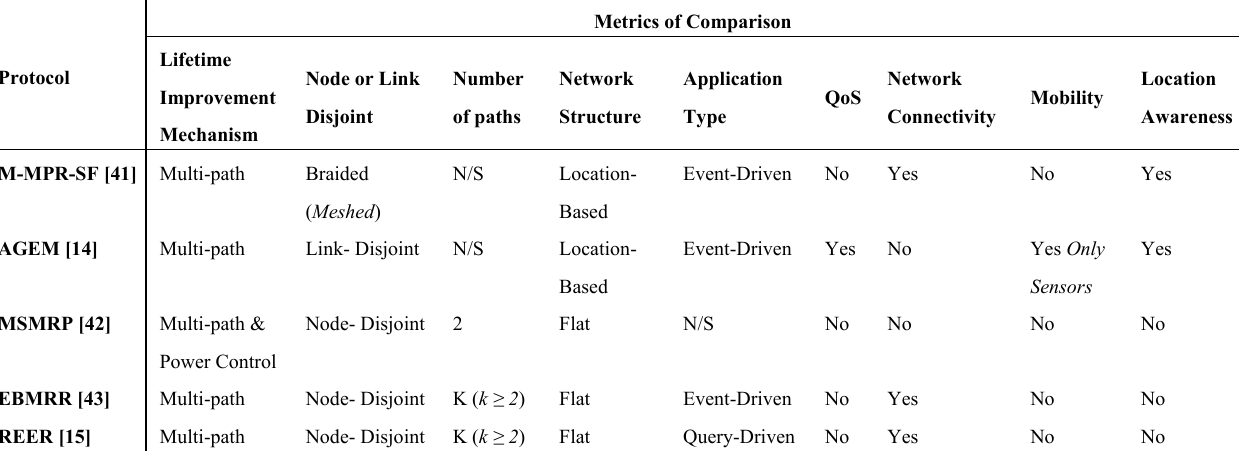
Table 2. Comparison of multi-path routing